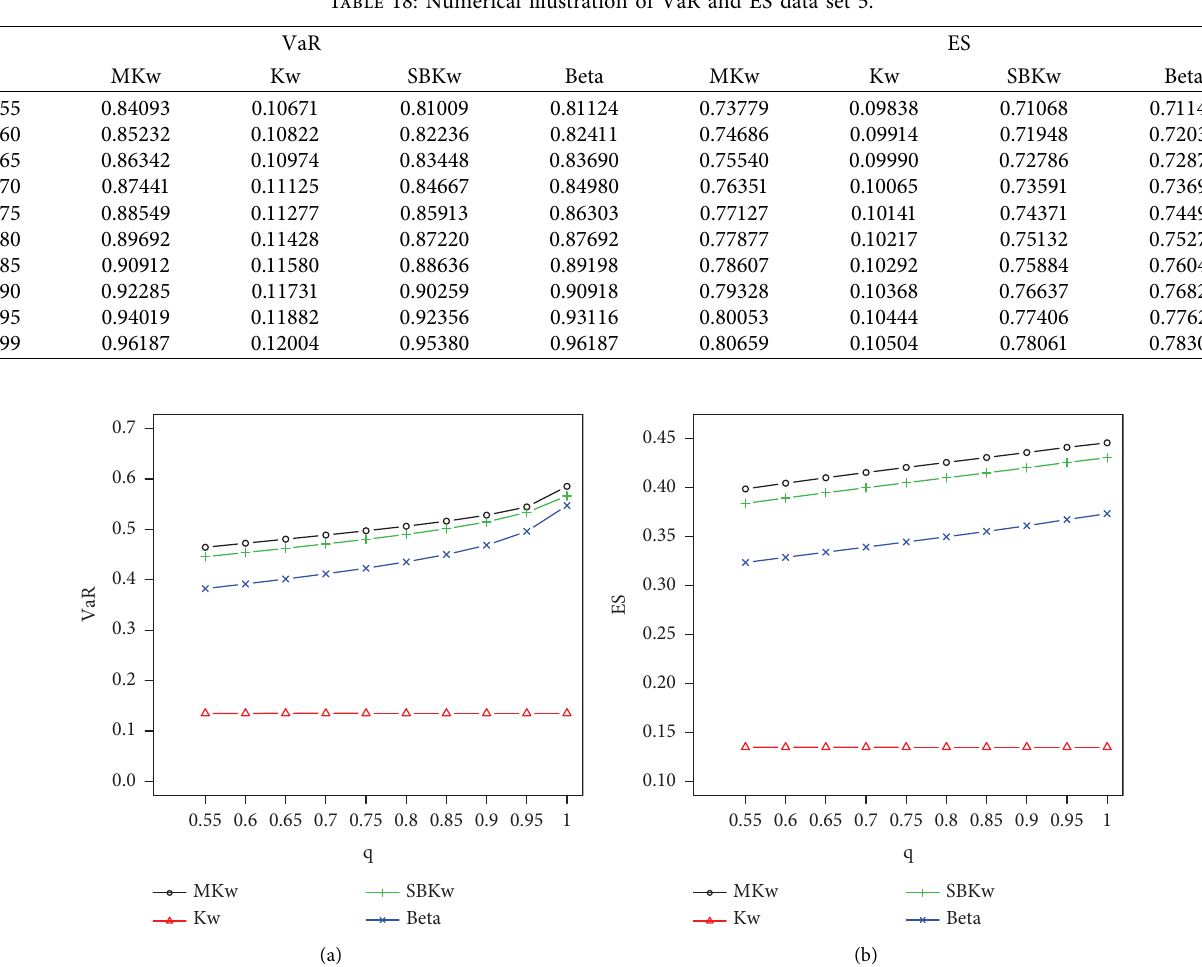
Table 18: Numerical illustration of VaR and ES data set 5.